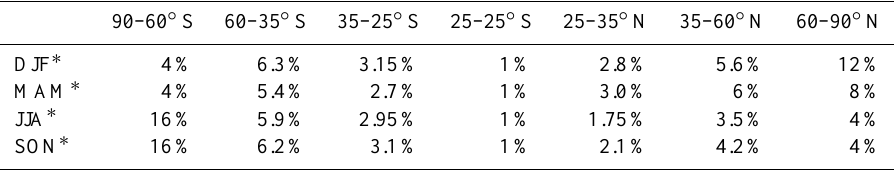
Table 1. Increase in stratospheric ozone column due to expected ozone recovery in the sensitivity run.